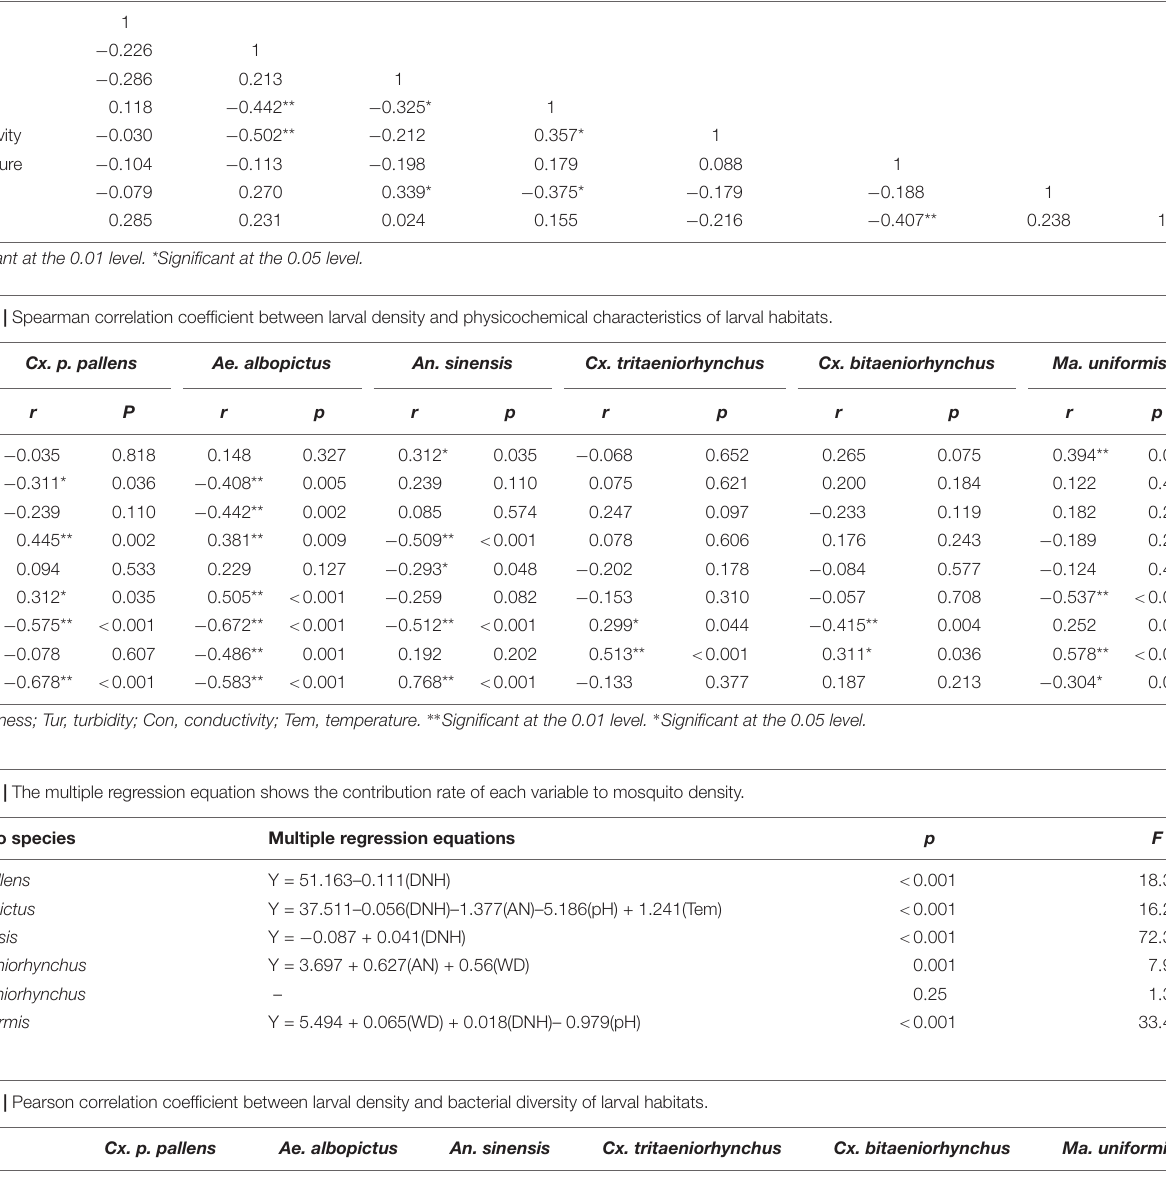
Hardness Turbidity